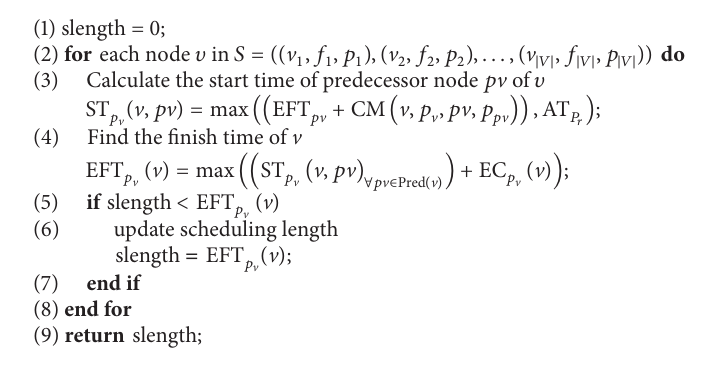
Algorithm 5: Fit( 𝑆 ) calculating the fitness value of a molecule and the processor allocation